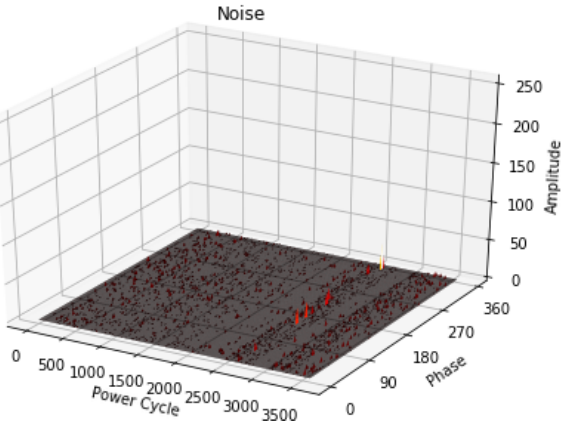
Figure 6. Example of noise in on-site